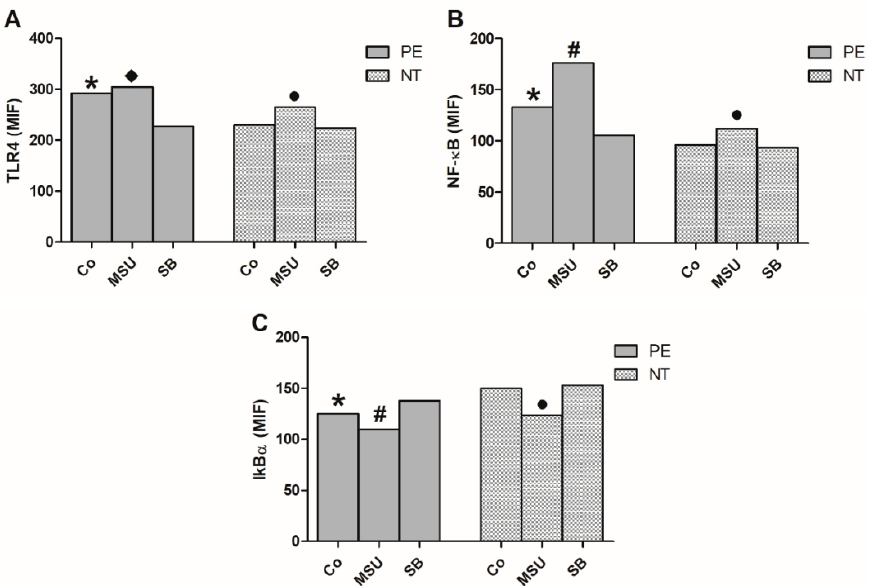
Figure 4. TLR4 ( A ), NF- κ B ( B ) and I κ B α ( C ) expression by monocytes. Monocytes from pregnant women with preeclampsia (PE) and NT pregnant women were cultured in the absence (Co) or presence of MSU or SB. Results are shown as the median. * p < 0.05 vs. NT Co, PE SB; # p < 0.05 vs. PE Co, PE